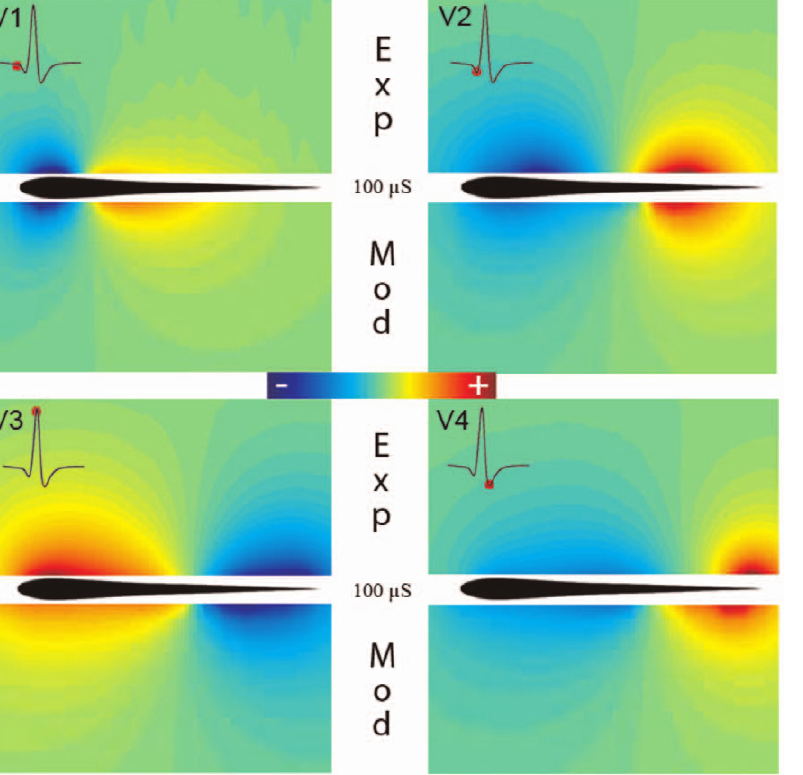
Figure 1. Comparison between experimental results and model predictions of the electric field generated by G.omarorum ’s EOD for a 100 m S/cm medium conductance. The colormaps compare the fields of potential experimentally measured in a horizontal plane (upper half) at the peak of each component (V1 to V4, marked at the insets as a red dot in the head to tail EOD) with the same fields predicted by the model (lower half).